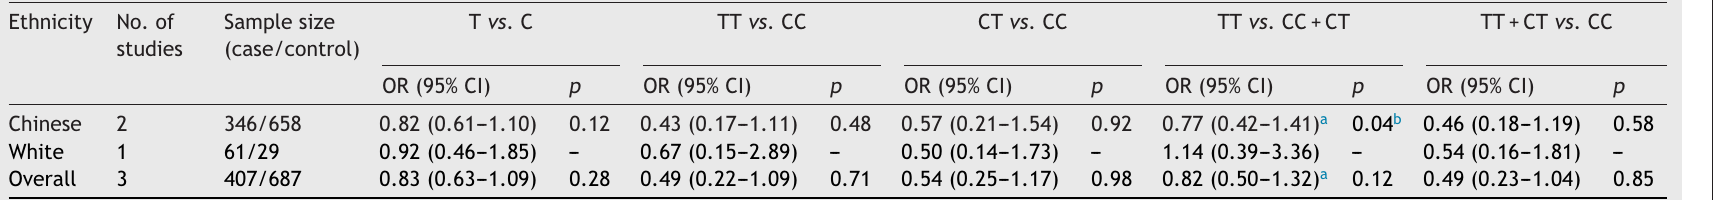
Subgroup analysis based on ethnicity for all genetic